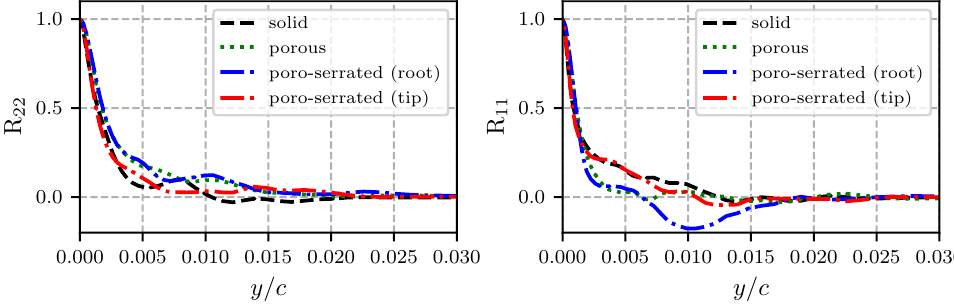
Figure 11. Autocorrelation functions of the wall-normal ( left ) and streamwise ( right ) velocity fluctu- ations with separation distances from the centreline in the normal direction at x / c =